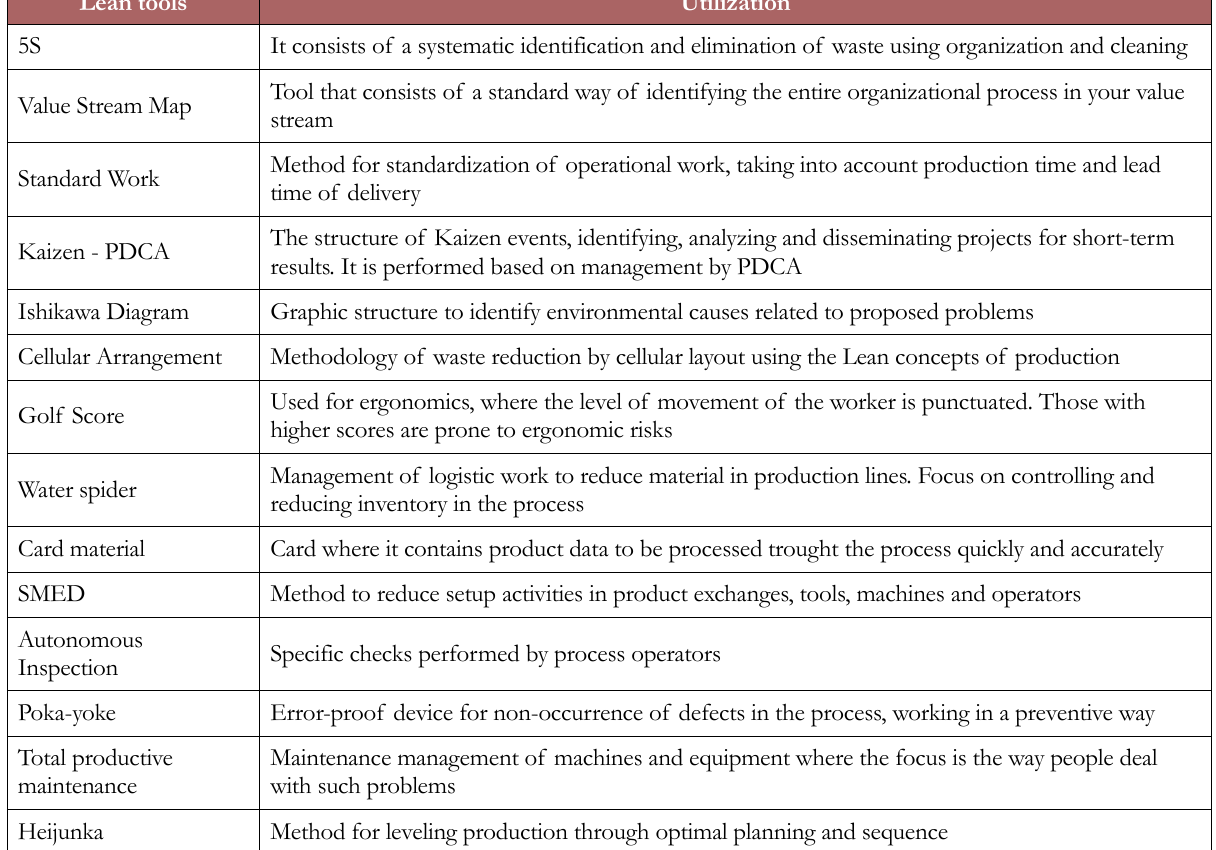
Table 3. Use of Lean tools in